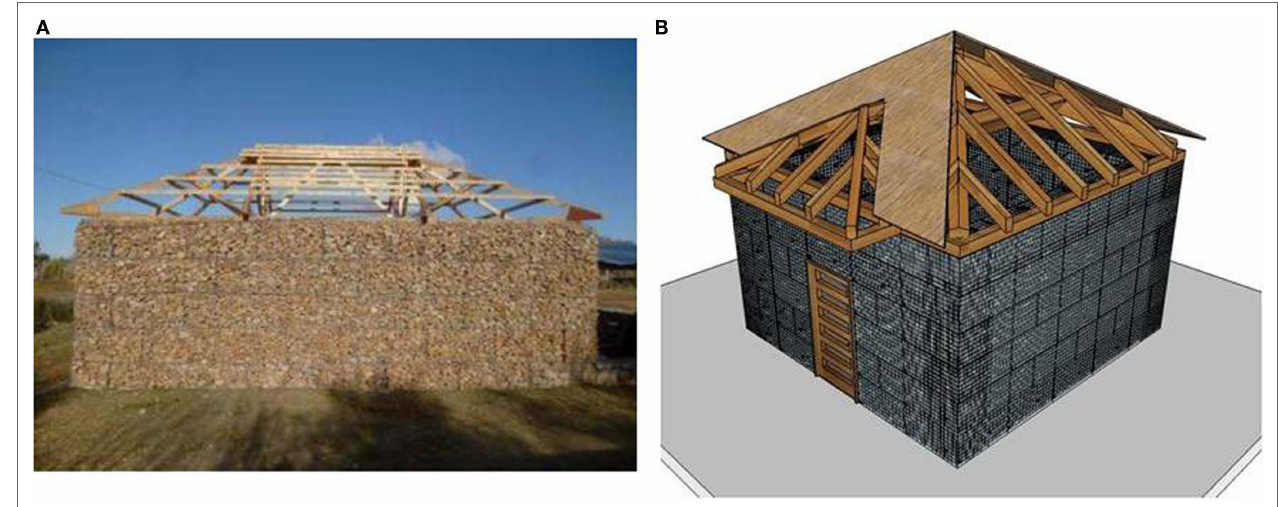
FIGURE 1 | (A) Illustrative photograph (courtesy from A&D—Architecture and Development —www.archidev.com working with architecture sans frontiers Nepal ). (B) Sketch of the considered gabion-box walls